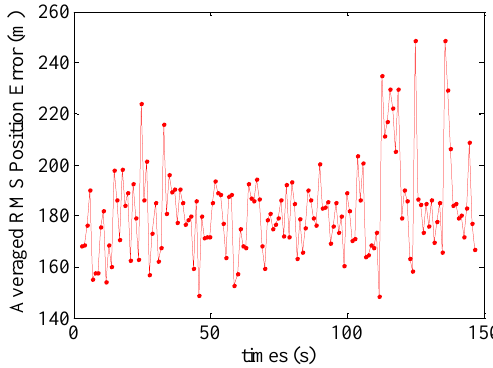
Figure 13. The estimated errors for the target I.